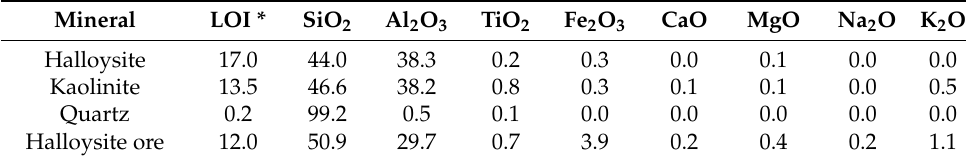
Table 1. Chemical analysis of pure halloysite, kaolinite, and quartz minerals.